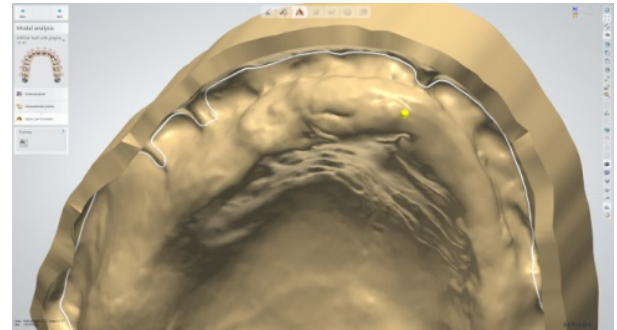
Figure 8. Designing the functional borders of the denture.